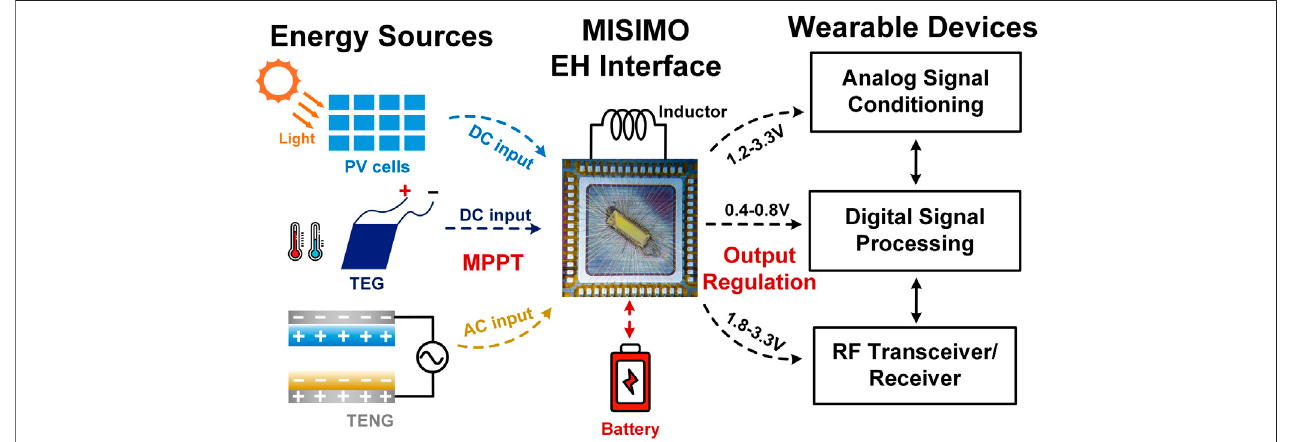
FIGURE 1 | The MISIMO EH interface in the applications of